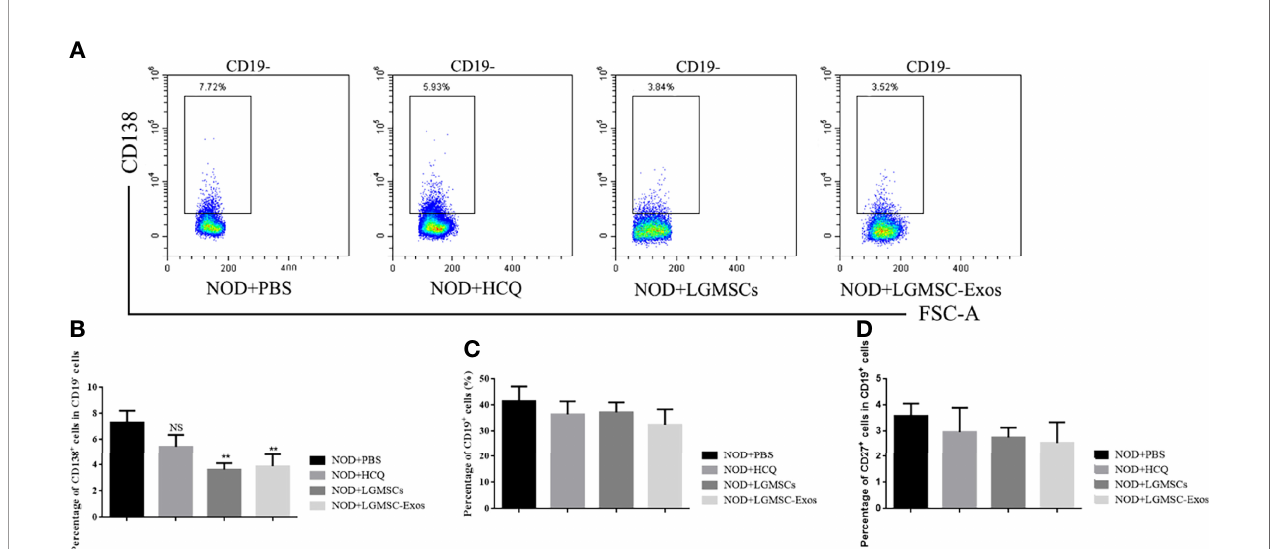
FIGURE 3 | Transfer of LGMSC-Exo-altered B cell subsets of lymphocytes into the spleen of mice. (A) Representative fl ow cytometry pro fi les of CD3 - CD19 - CD138 + plasma cells from NOD mice after different treatments; (B) Percentages of CD138 + cells among CD19 - cells. Data represent the mean ± standard deviation (SD;